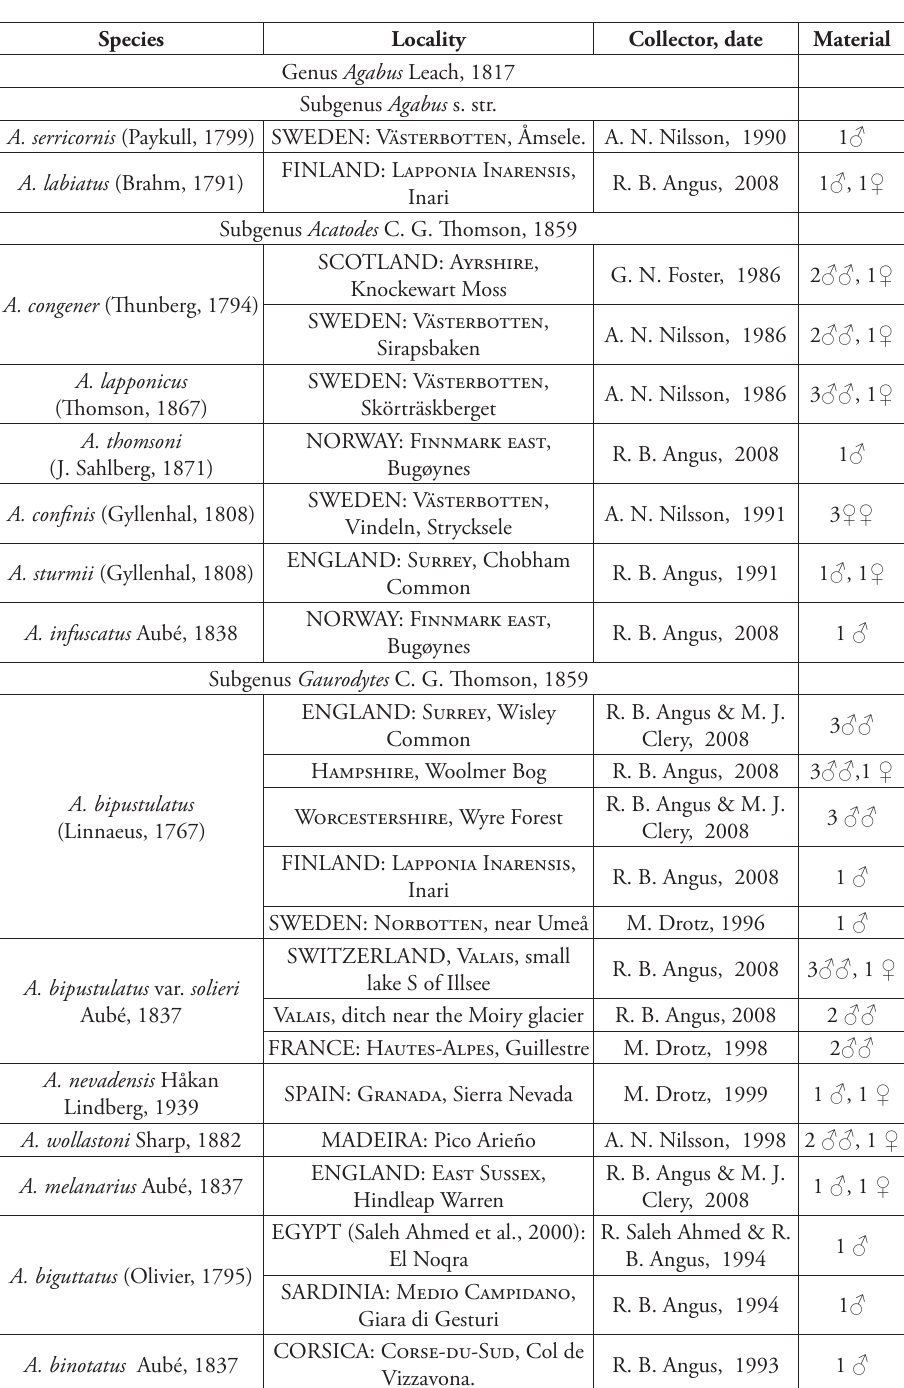
table 1. Material